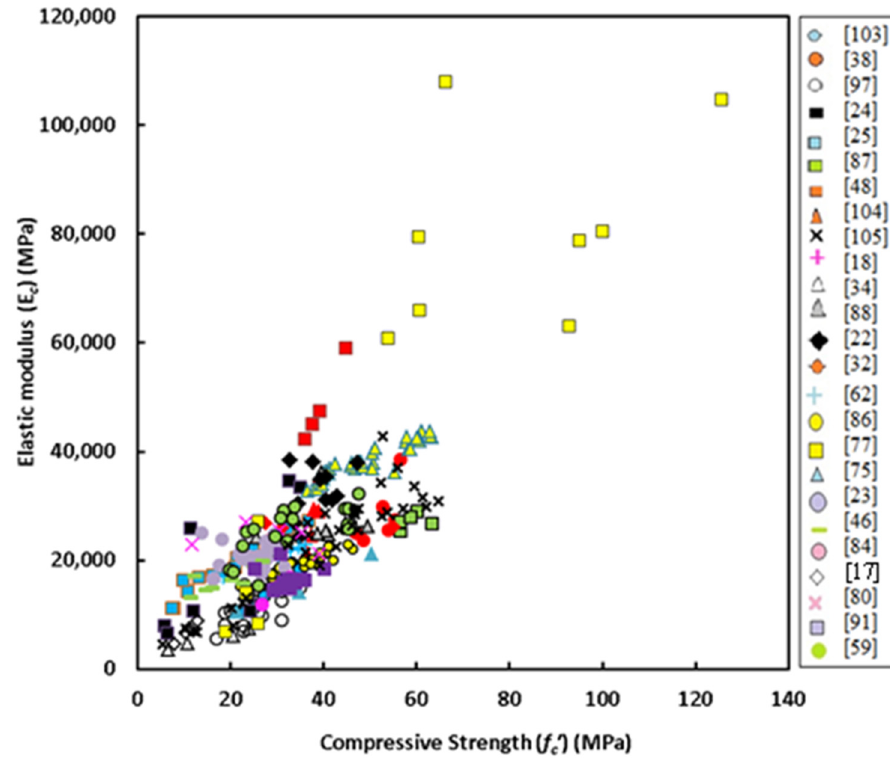
Figure 4. Variation of elastic modulus with compressive strength of GPC.